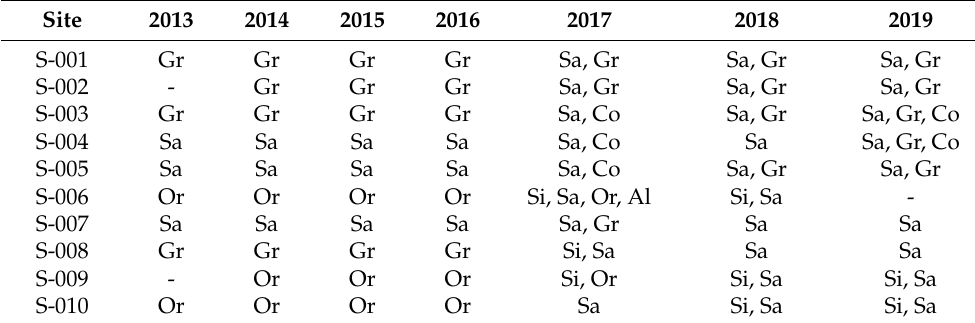
Table 2. Substrate types present by year at sampling sites for a shoreline seine survey on the St. Clair and Detroit rivers. Si = Silt, Sa = Sand, Gr = Gravel, Co = Cobble, Or = Organic, and Al = Algae. “-” indicates no data. Sites are arranged from upstream to downstream (top to bottom).